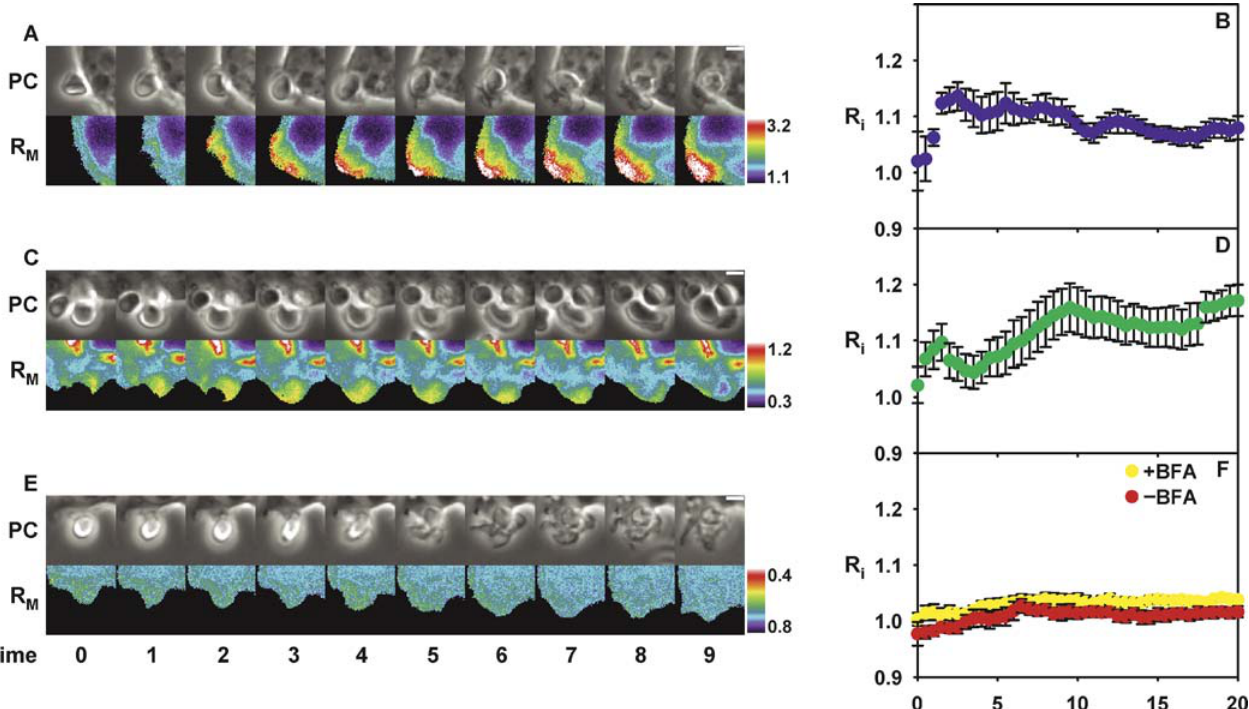
Figure 2. Ratiometric Microscopy of Arf6-YFP, ARF1-YFP, and YFP-NGAT at the Phagosome Ratiometric fluorescence microscopy of macrophages expressing ARF1-YFP, ARF6-YFP, or YFP-NGAT chimeras with soluble CFP during phagocytosis. (A, C, and E) Phase contrast (PC) and ratiometric images of macrophages during the phagocytosis of IgG-opsonized erythrocytes. Scale bars are 3 l